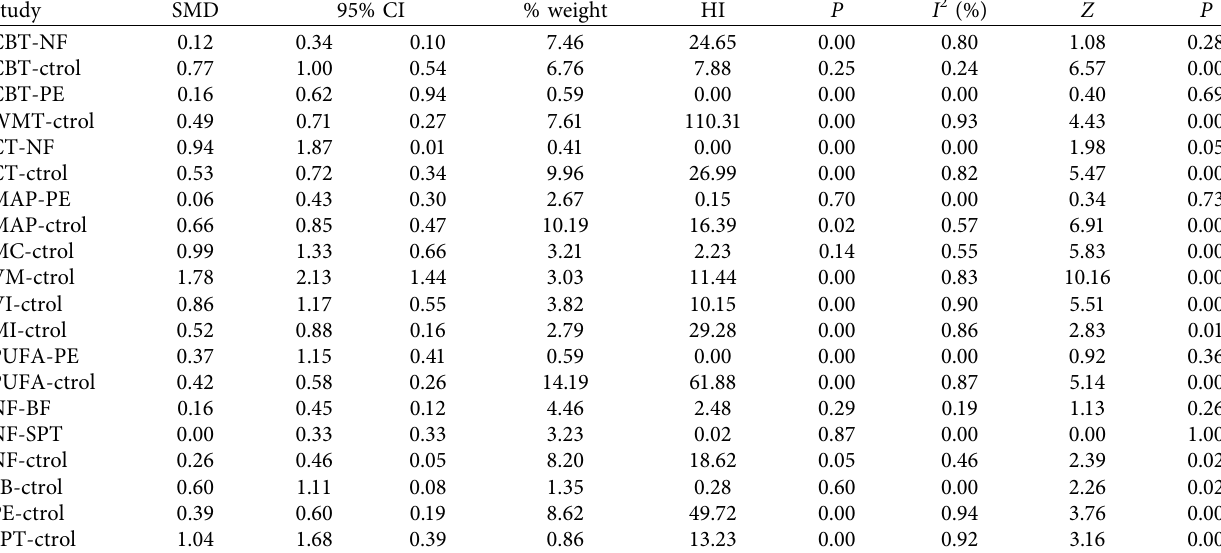
Table 2: Homogeneity